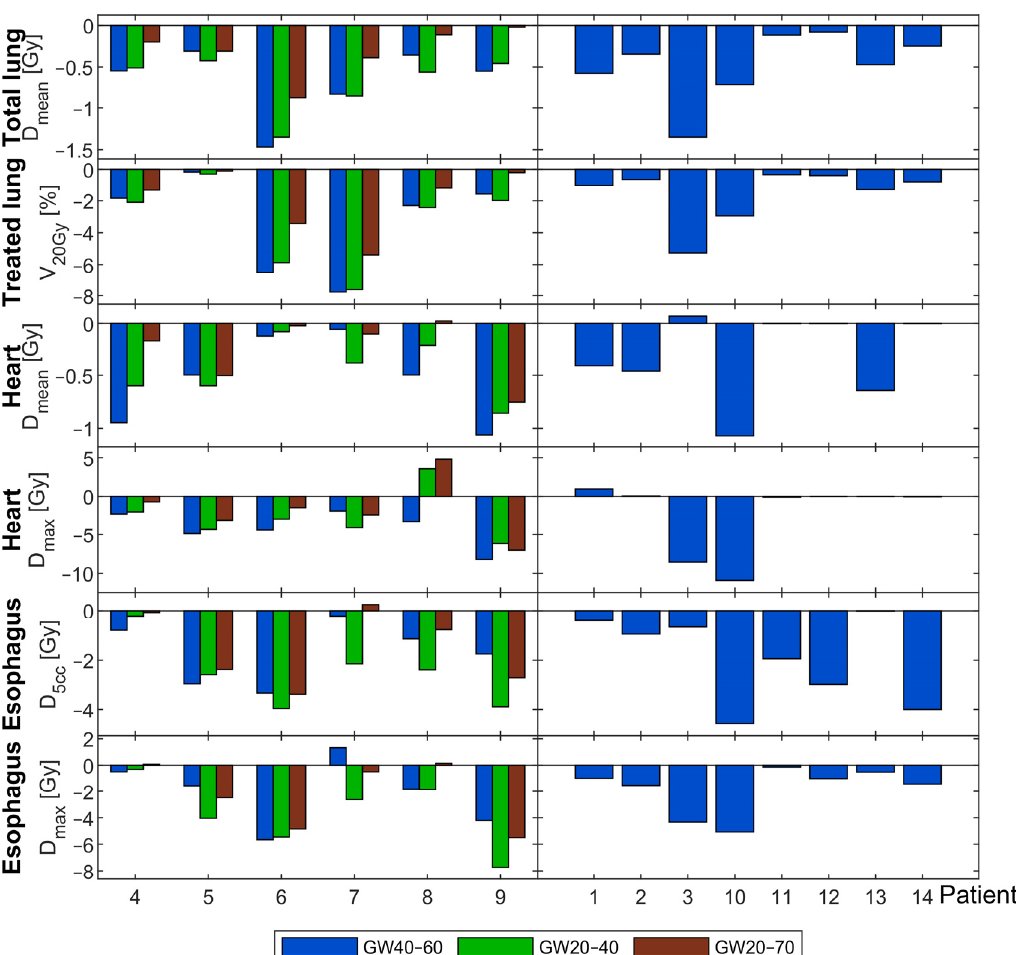
Figure 3. Left : Changes in dosimetric parameters for different GWs for a subset of 6 patients. Blue bars refer to the differences between GW40–60 compared to no gating; green bars refer to differences between GW20–40 compared to no gating; brown bars refer to the differences between GW20–70 to no gating. Right : Dosimetric changes between GW40–60 and no gating for the residual 8 patients.